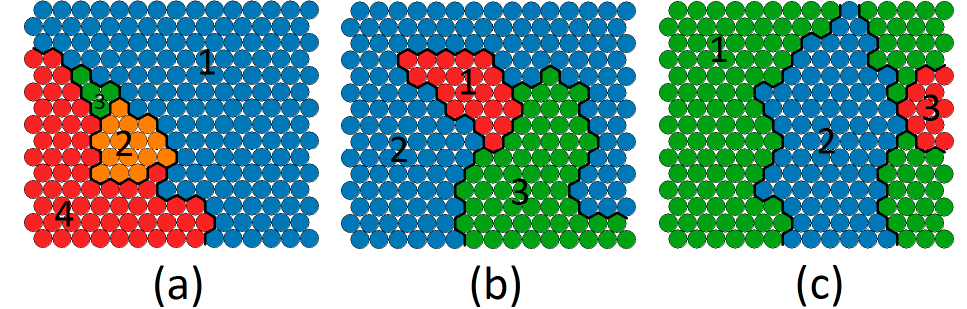
Figure 3. Sub-clusters produced based on patient demographic data ( a ) demographic sub-clusters of the first satisfaction cluster, ( b )demographic sub-clusters of the second satisfaction cluster, ( c ) demographic subclusters of the third satisfaction cluster.